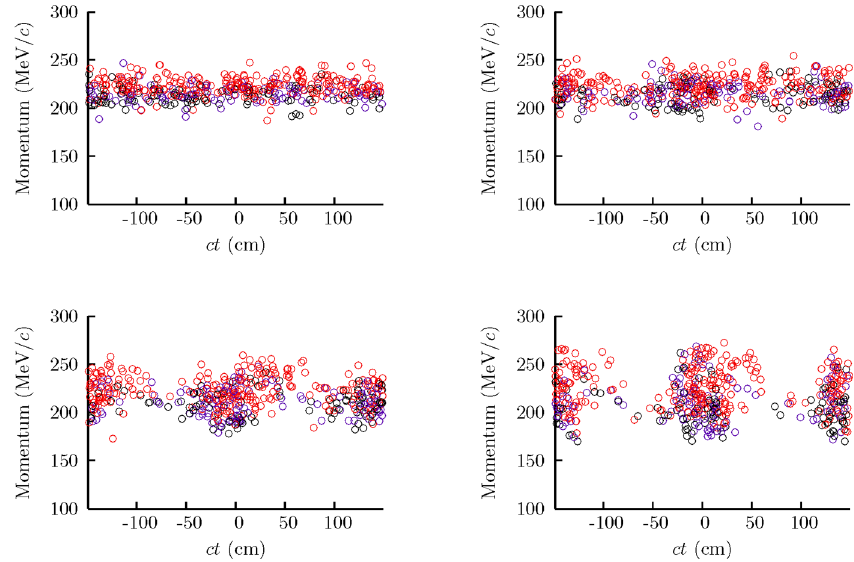
FIG. 17. (Color) Evolution of beam in buncher. Plots are at the beginning of the buncher (top left), and at the ends of the three bunching stages (top right, bottom left, and bottom right, in that